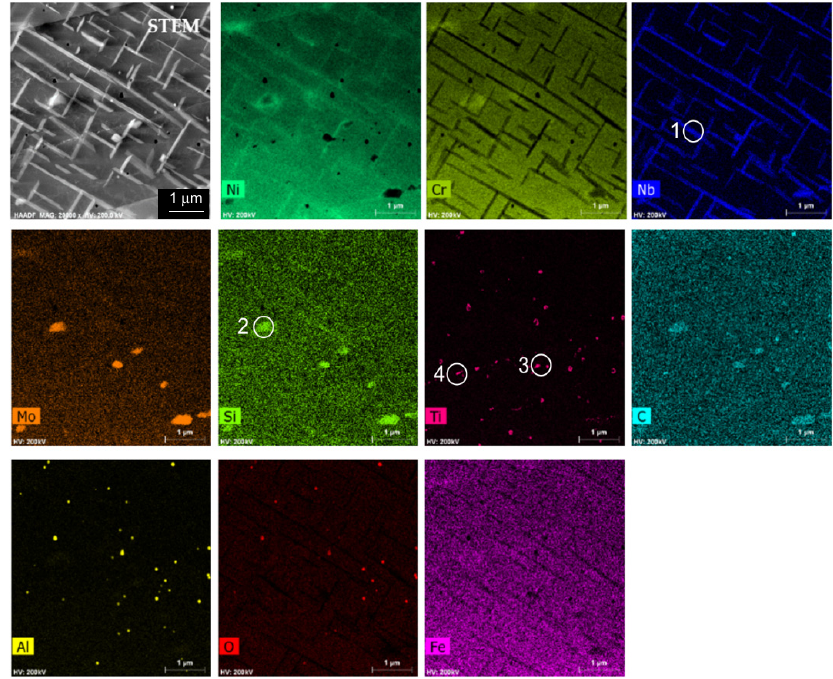
Figure 6. STEM-HAADF image together with EDS maps of chemical elements distribution in the L- PBF Inconel 625 stress-relieved and subsequently annealed at 800 ◦ C for 500 h; exemplary precipitates of groups 1–4 are marked. Table 2. Average chemical composition ± standard deviation (in wt. %) of the matrix and designated groups of precipitates in L-PBF Inconel 625 annealed at 800 ◦ C for 500 h. Average Chemical Composition ± Standard Deviation (in wt. %) O C Fe Ti